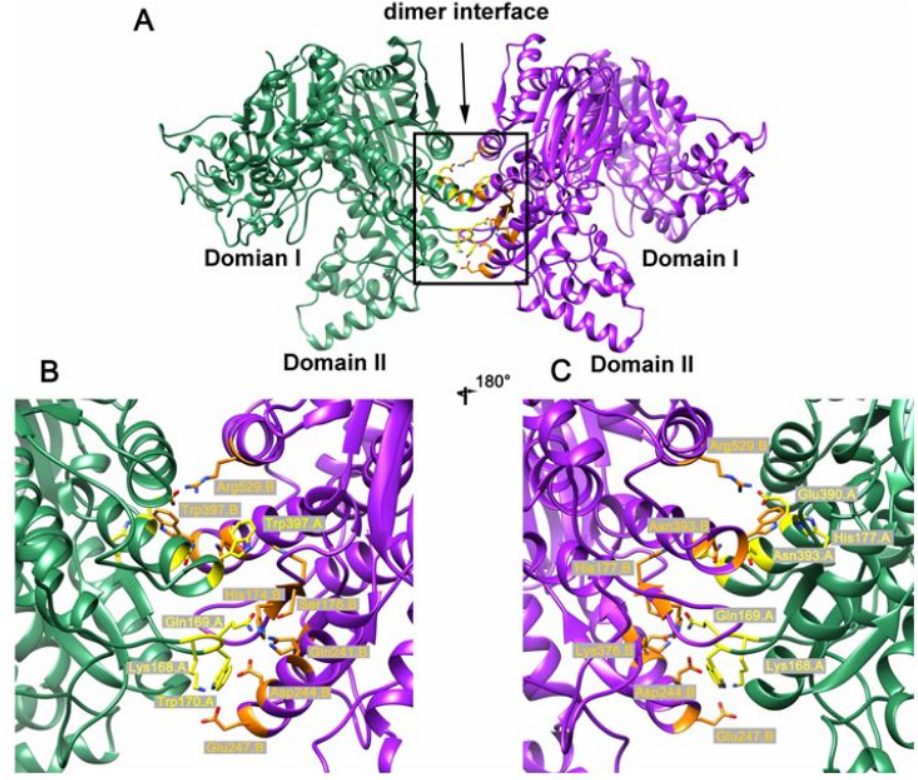
Figure 2. The overall structure of AbIDH2. ( A ) AbIDH2 shows a dimeric structure and each subunit contained a domain I and a domain II. ( B , C ) These images show the hydrophobic interactions formed on the interface platform that stabilize the dimeric assembly. The interface platform centers around the three parallel helices ( α 4, α 12, and α 17) and one adjacent loop from the domain II in each